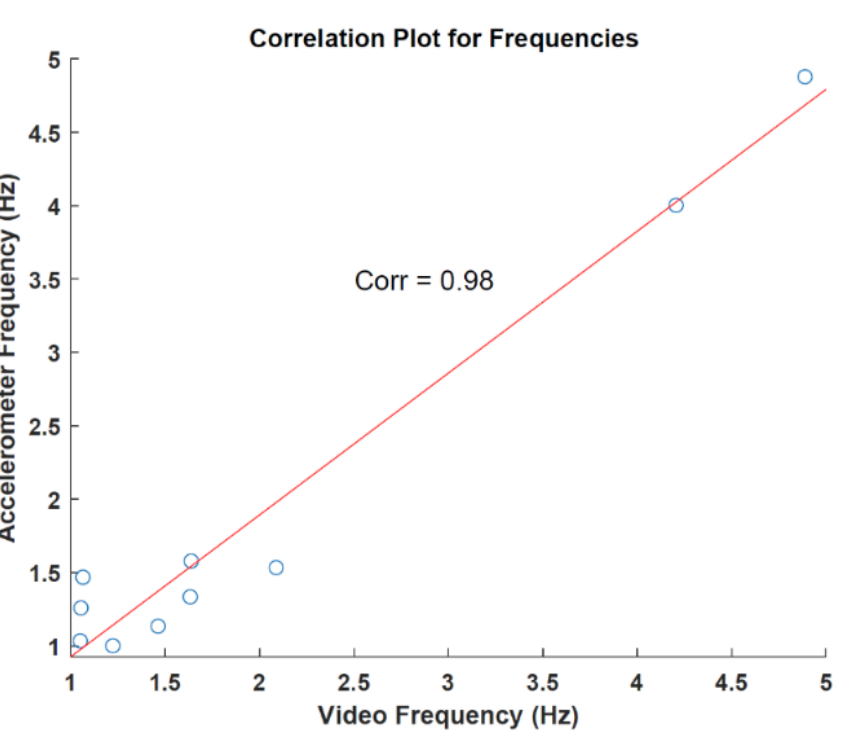
Figure 7. Correlation analysis for frequencies.